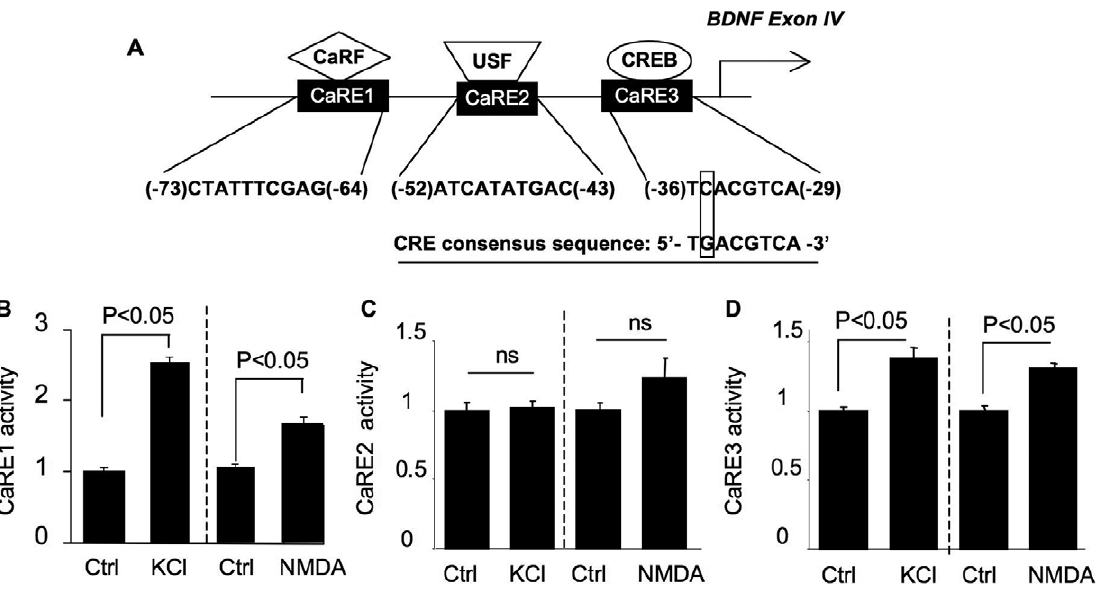
Figure 4. CaRE1 and CaRE3, but not CaRE2 activity, are stimulated by calcium influx. (A) Schematic illustration of the relative positions of CaRE1, 2, and 3 in the promoter IV region of BDNF gene. These calcium responsive elements are binding sites for transcription factors CaRF, USF, and CREB. The nucleotide sequences of CaRE1, 2, 3, and CRE are also shown. From (B) to (D), cortical neurons at DIV 9 were transfected with CaRE1, or 2, or 3-luciferase reporter constructs plus TK-pRL. As a control, the backbone construct (SV40-luciferase) and TK-pRL were co-transfected for normalization purposes. On DIV 11, neurons were treated with 50 mM KCl or 20 m M NMDA. Dual luciferase assay was performed after the six-hour incubation with KCl or NMDA. Neurons used for KCl treatments (both the control and the stimulated groups) were pre-treated with APV and CNQX to block NMDAR and non-NMDA type glutamate receptors, respectively. Neurons used for NMDA treatment (both the control and the stimulated groups) were pre- treated with nifedipine and CNQX to block L-VGCC and non-NMDA type glutamate receptors, respectively. The firefly luciferase activity was normalized to Renilla-luciferase. Then, CaRE-mediated activity was normalized with SV40 activity. SV40 activity was obtained from neurons co- transfected with SV40-luc and TK-pRL. ns: not statistically significant between stimulated and control neurons. For all experiments in this figure, data were collected from 16 independent preparations for each treatment.